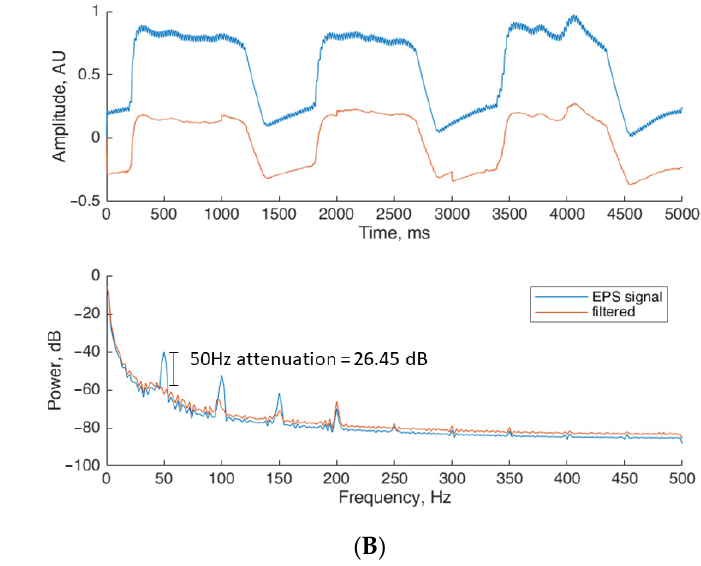
Figure 4. ( A ) Unconventional electric field sensors placed on the participant’s wrist for EMG bio- signal collection. ( B ) Experimental results when applying the proposed denoising method on EMG bio-signals. Figure 4B: (top) Human EMG bio-signal collected using the EPS sensors before (labelled EPS signal) and after the denoising method is applied (labelled as filtered); (bottom) PSD measure- ment before and after the denoising method is applied, showing an attenuation of 21.25 dB in the 50Hz component.